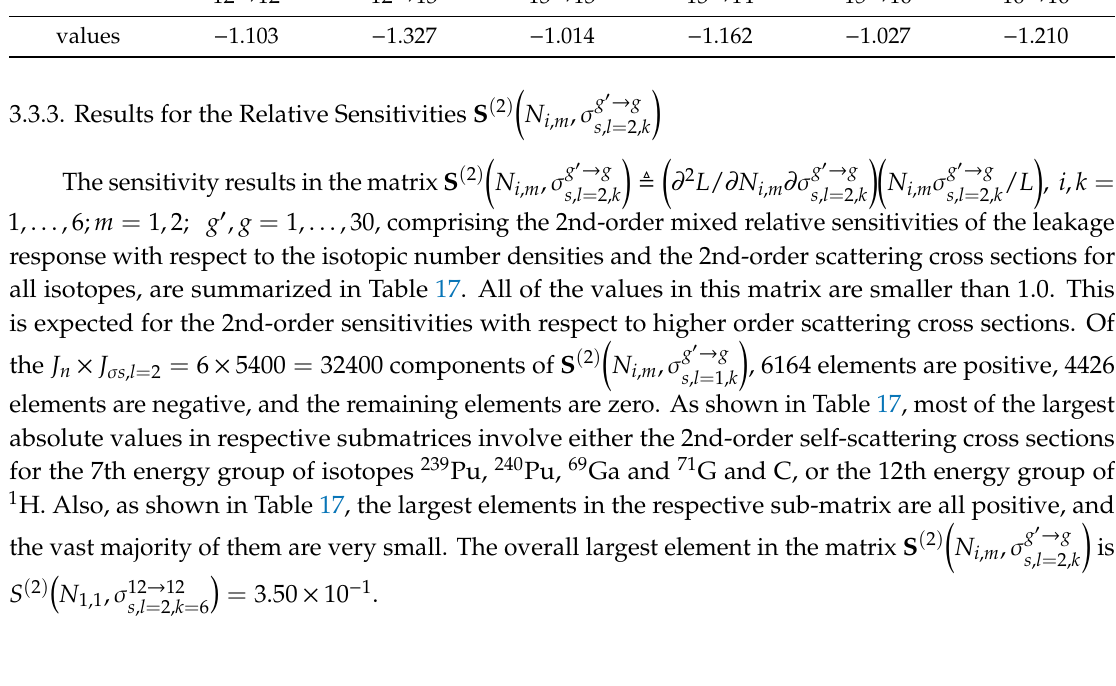
(cid:17) , g (cid:48) , g = 1, ... ,30 with absolute values greater than 1.0.